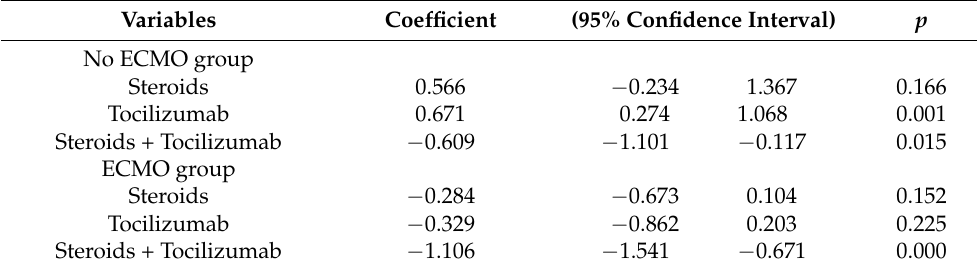
Table 2. Mixed-effects linear regression model involving the independent variables related to the log-lymphocyte count in both study groups, adjusted for SOFA.